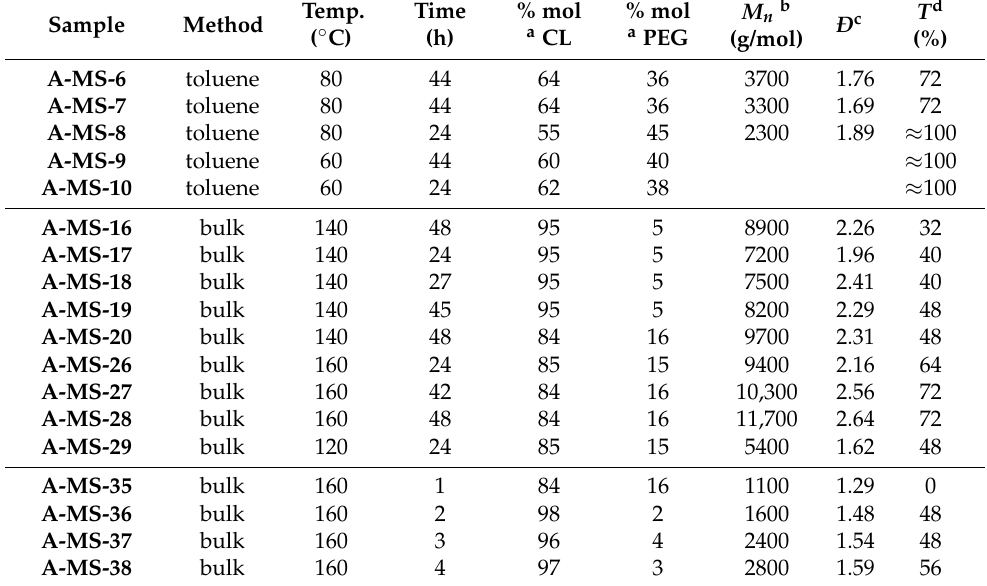
Table 2. Copolymerization of rac -lactide ( rac -LA) and PEG in the presence of Zr(Oct) 4 .